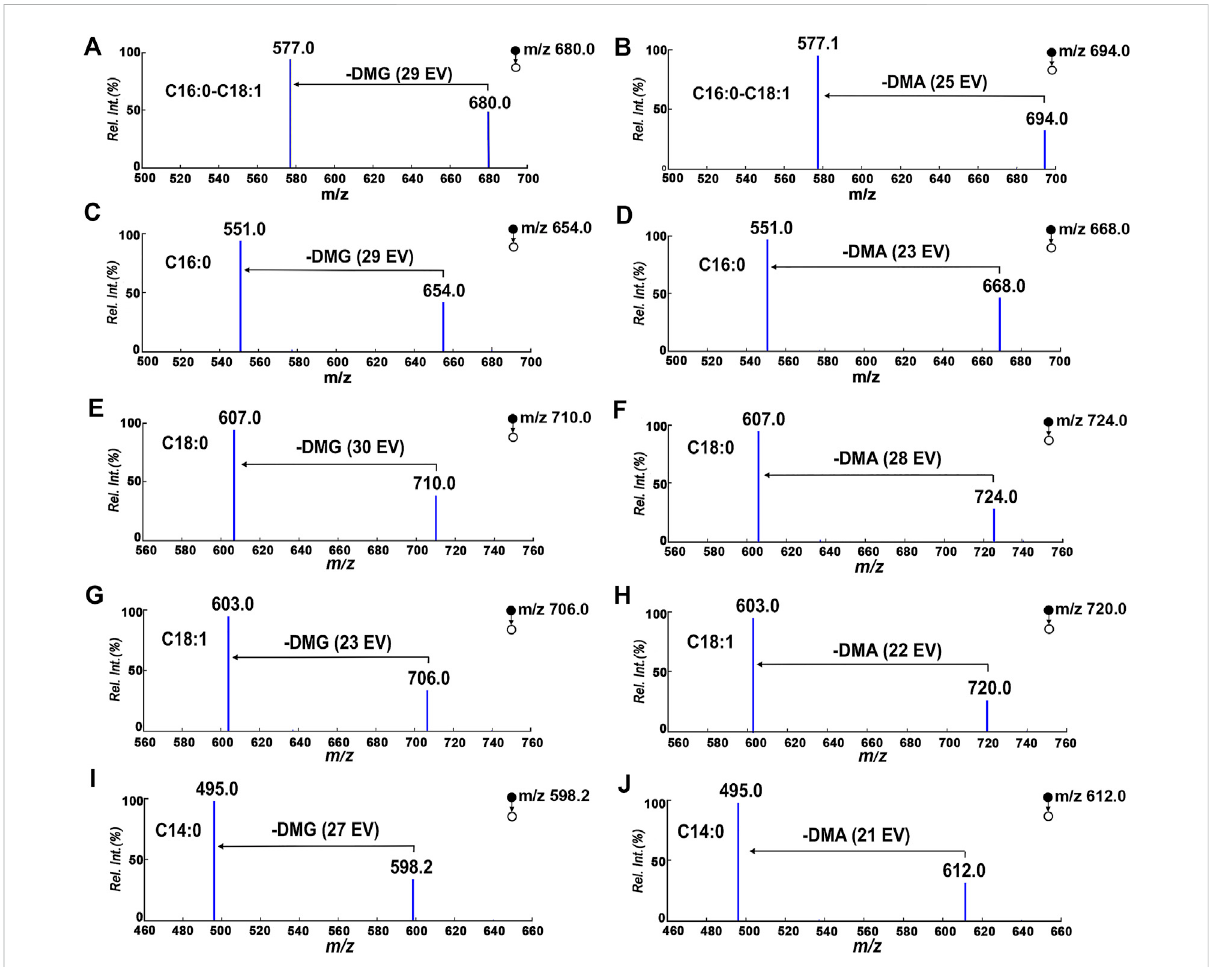
FIGURE 5 Multiple reaction monitoring beam-type CID of DMG -DAGs and DMA -DAGs in positive mode. (A,B) DAG16:0/18:1/0, (C,D) DAG16:0/16:0/0; (E,F) DAG18:0/18:0/0, (G,H) DAG18:1/18:1/0; (I,J) DAG14:0/14:0/0.